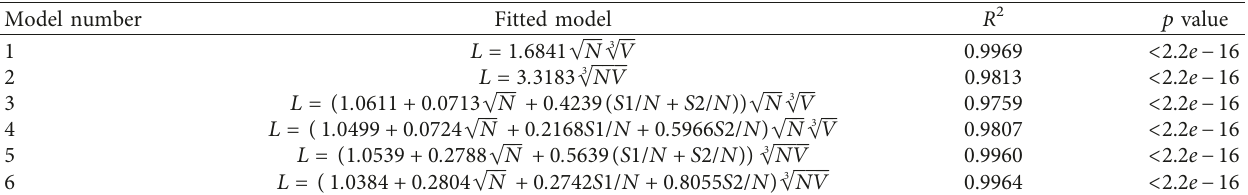
Table 8: Fitted models.